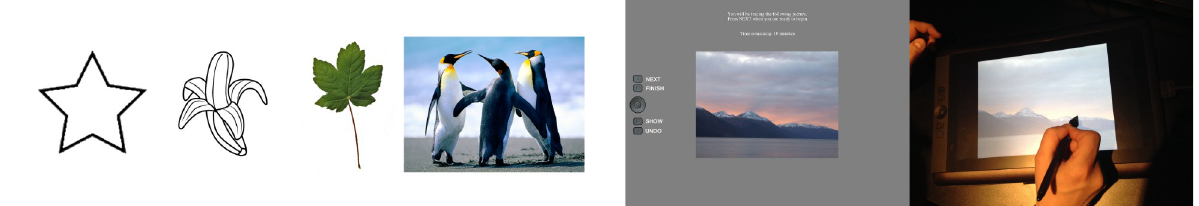
Fig 1. Setup for Experiment 1. Left: Images similar to these were use as practice stimuli to familiarize participants with the tracing task and program interface. Images under Creative Commons Licence by Supachoteamorn, Aryadna Pons, Ksanyi, and Christopher Michel. Right Experiment setup with a pen display graphics tablet. The computer screen displayed instructions and the original 800x600 pixels photograph as reference during the trial. The graphics tablet displayed a 1440 x 1080 pixels copy of the image with a semi-transparent overlay for tracing. The Next, Finish, Show, and Undo functions corresponding to each button on the side of the graphics table were displayed during the entire experiment. Images by the authors. The set of 18 photographs are available at: https://osf.io/x9uj5/.